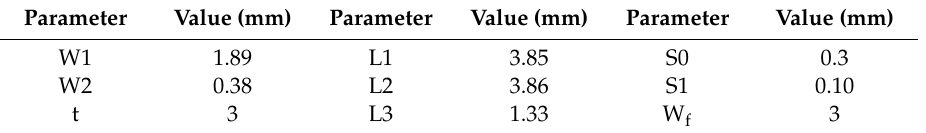
Figure 5. The simulated S-parameters of filter at 3.5 GHz. Table 2. Different parameters of the filter and their values at 2.4 GHz.